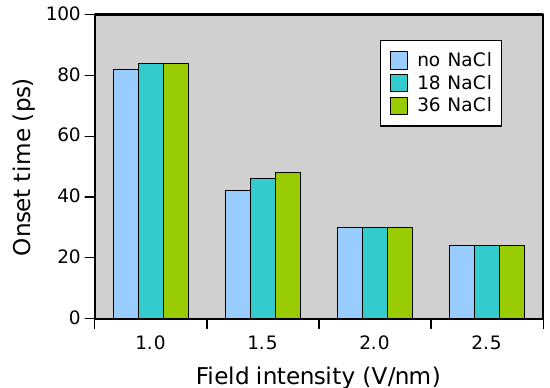
Figure 17. Production times at which the total mass transfer through the plane at z = 20 nm exceeded 2000 Da vs. the intensity of electric field for different numbers of NaCl ion pairs (see the legend). Systems with eight 5.26-kDa chains were used. Graph made by Gnumeric [57].